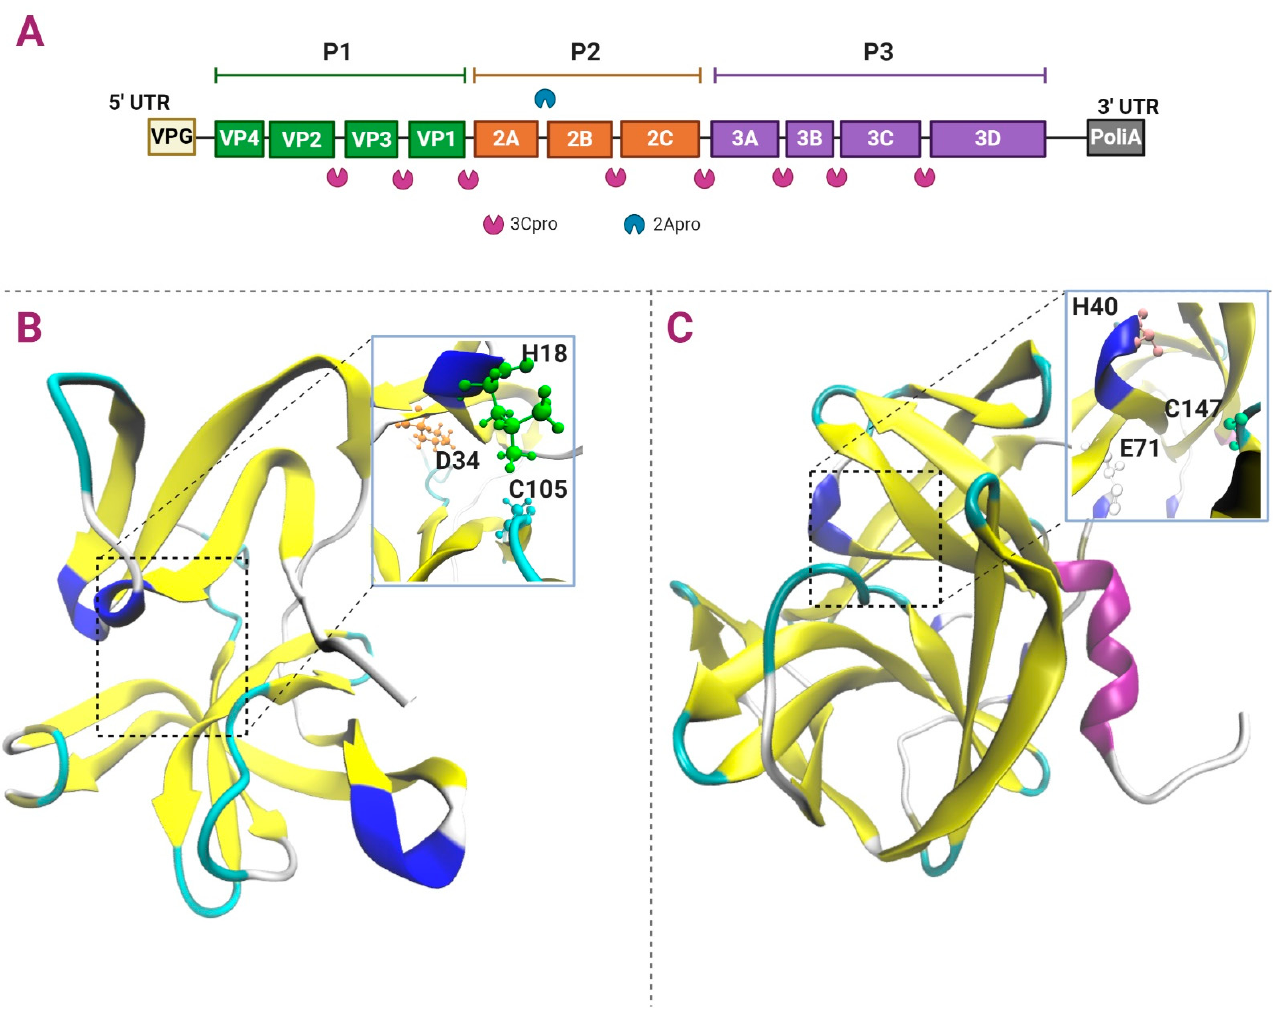
Figure 4. Polyprotein cleavage and structure of Enterovirus 2Apro and 3Cpro. Panel ( A ) shows the Enterovirus RNA genome that encodes four structural and seven non-structural proteins and the cleavage sites by 2Apro and 3Cpro. Panel ( B ) shows 2Apro and its catalytic triad H18, D34, and C105, from RV (PDB ID: 2M5T). Panel ( C ) shows 3Cpro and its catalytic triad H40, E71, and C147, from PV (PDB ID: 1L1N). Color code: helix- α in purple, 3 10 helix in blue, β -sheets in yellow, β -bridge in tan, and turn in cyan.